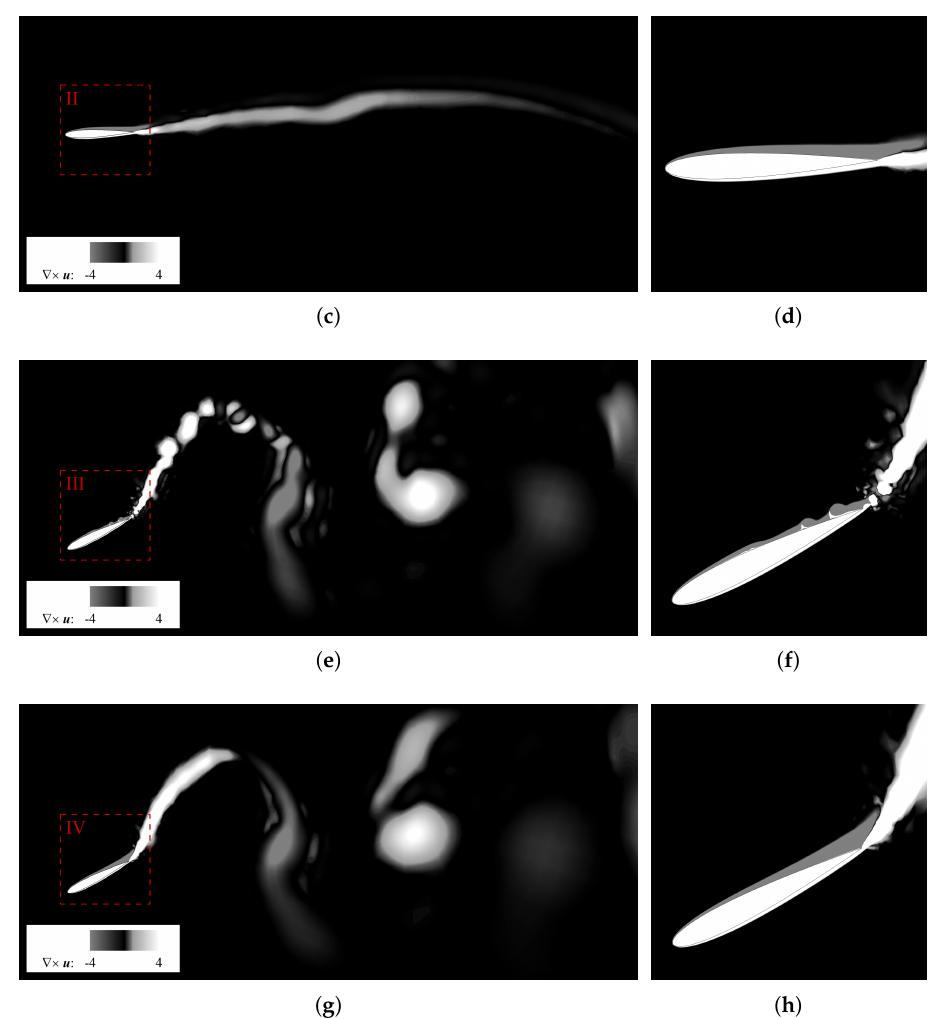
Figure 5. Contour plot of the instantaneous vorticity field for α max = 15 ◦ using the transition and fully turbulent models. The snapshots are taken at Φ ≈ 0.183 for St = 0.1 and at Φ ≈ 0.385 for St = 0.45. ( a ) St = 0.1, SA-BCM; ( b ) detail I; ( c ) St = 0.1, SA; ( d ) detail II; ( e ) St = 0.45, SA-BCM; ( f ) detail III; ( g ) St = 0.45, SA; ( h ) detail